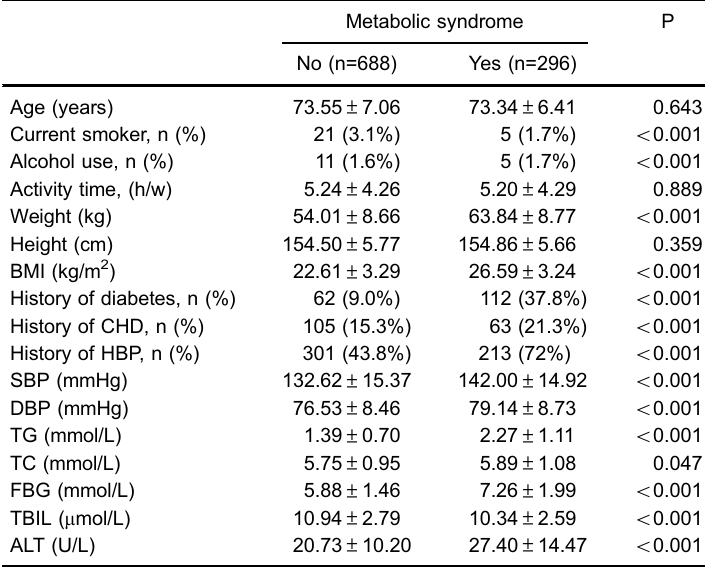
Table 2. Characteristics of the female participants according to metabolic syndrome status.